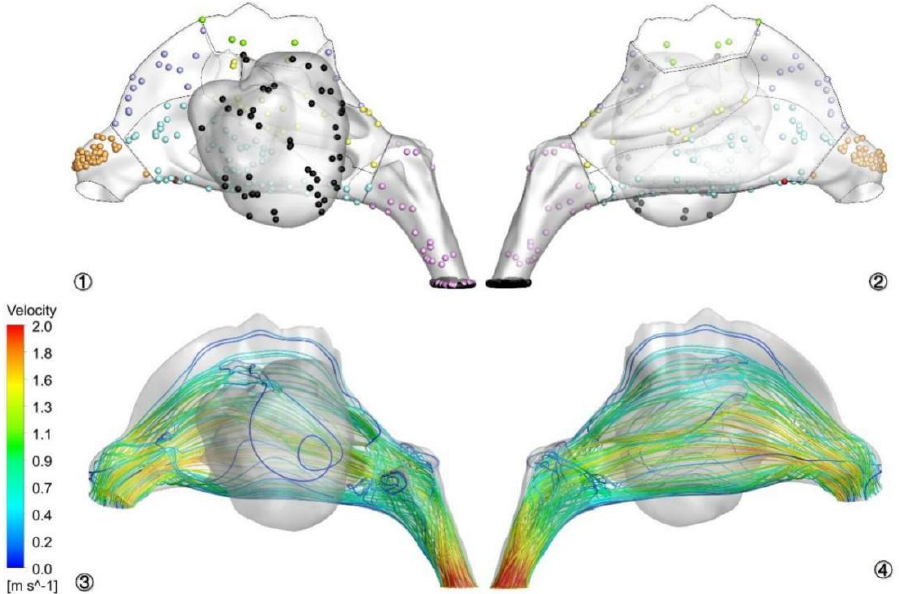
Figure 7. Under 15 L/min inspiratory condition in lying position, ① and ② show the deposition diagrams of A. niger spores on the nasal cavity mucosa ( ① left view, ② right view); ③ and ④ show the particle trajectories of A. niger spores moving with airflow ( ③ left view, ④ right view).